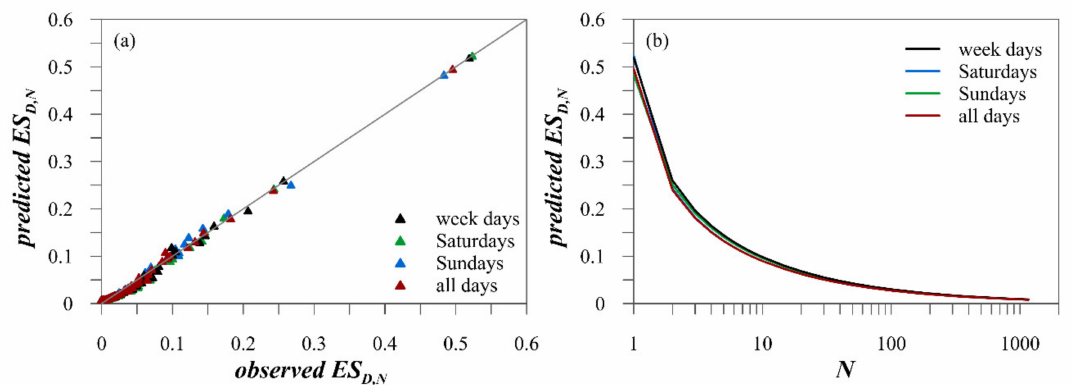
Figure 7. ( a ) Accordance between the standard error estimated for D = D max by Equations (9) and (11) for all the Clusters. ( b ) Comparison among calibrations of Equation (11) performed on the di ff erent Clusters for D = D max